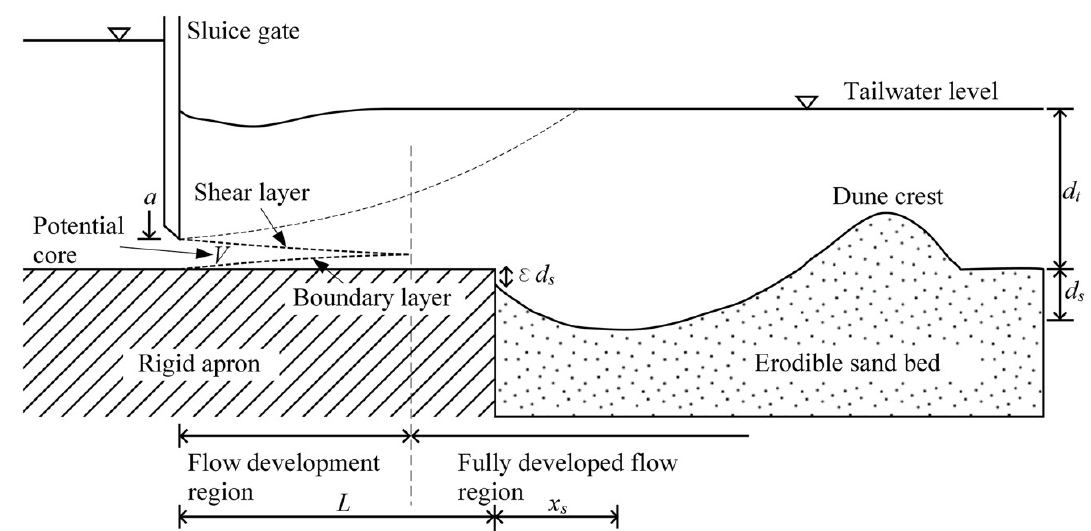
Figure 1. Scour hole under a wall jet .